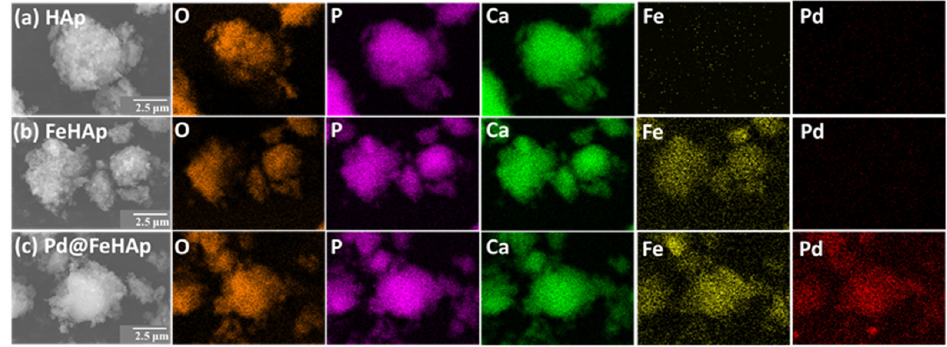
Figure 3. SEM-EDX images of ( a ) HAp, ( b ) FeHAp, and ( c ) Pd@FeHAp.